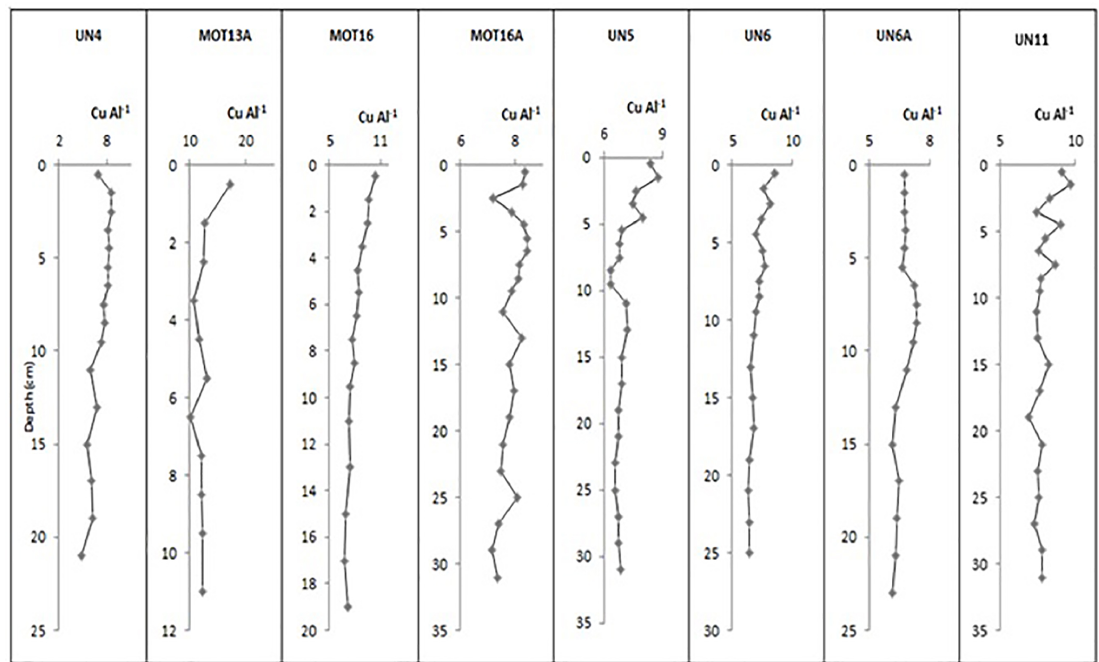
Figure A11. Vertical distributions of Cu Al − 1 × ( 10 4 ) in sediment cores. The ratios in the coarse cores MOT13A, MOT16 and UN4 are calculated at the fine-sediment fraction ( < 63µm).